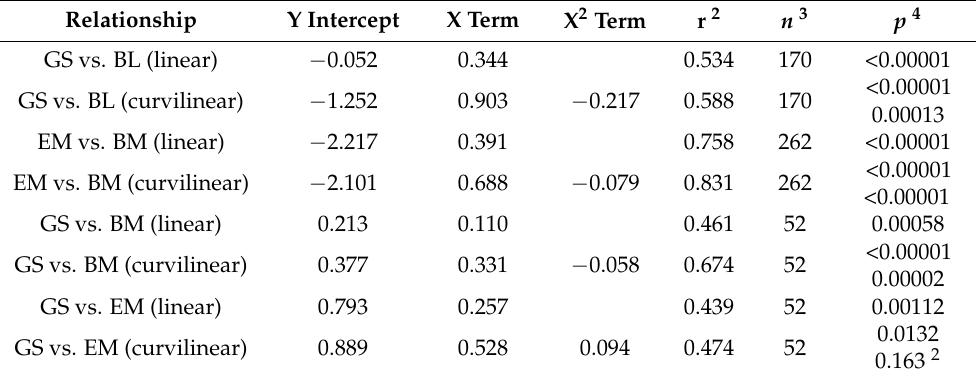
whether the curvilinear relationship is a significantly better fit than the linear relationship.